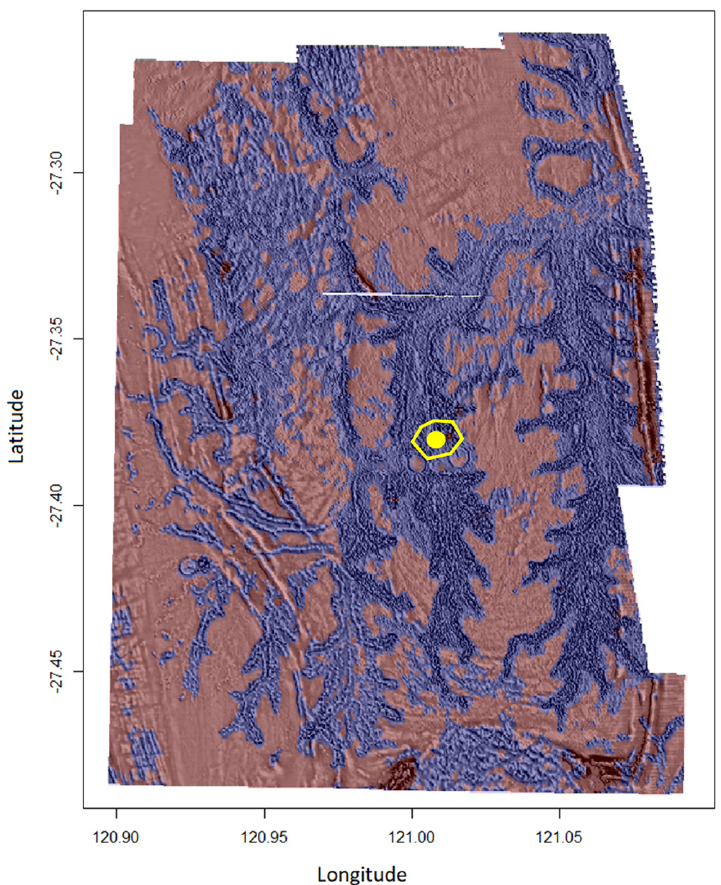
Figure 6. Processed high-resolution aeromagnetic layer for the Bronzewing area overlain by the predicted results via the SRF classifier. The blue colour represents the areas predicted as the positive class whereas the red colour represents the areas predicted as the negative class. The yellow marker shows the point location of the main deposit, with a yellow outline giving the approximate envelope of the mineralised ferricrete unit. Table 4. Confusion matrix for the SRF classifier—Bronzewing area.